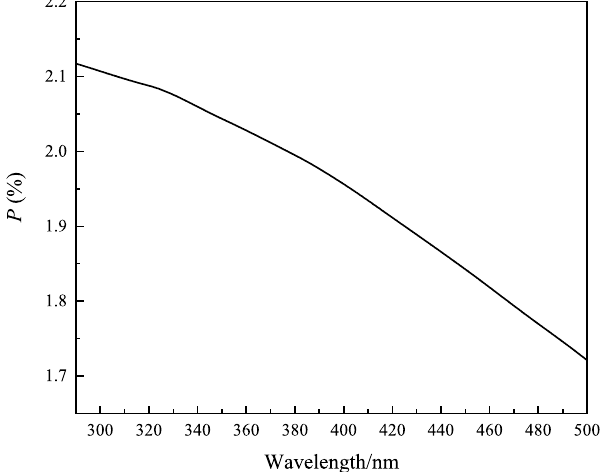
Figure 13. The curve of polarization degree of UV collimator as a function of